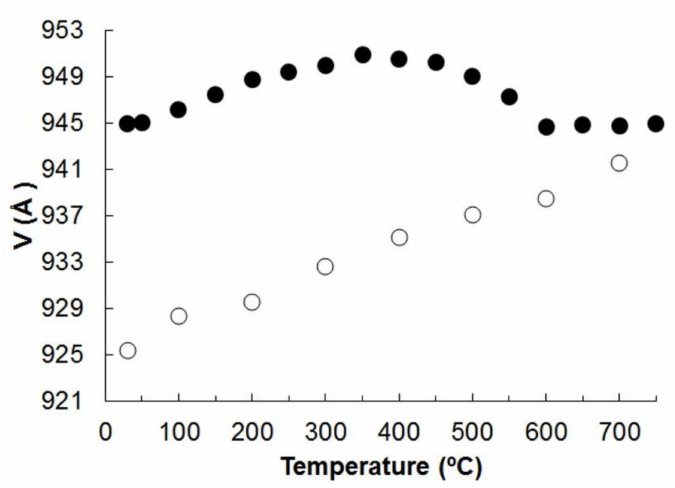
Figure 6. Unit cell volume of potassic-hastingsite vs temperature. Symbols: solid for the heating experiment; empty for the cooling. Estimated standard deviations are smaller than the symbol